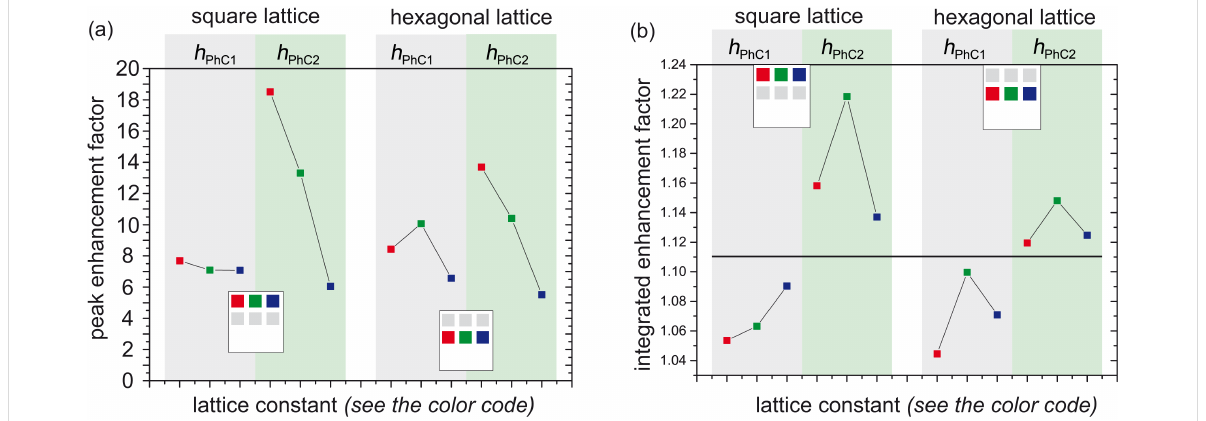
Figure 5: (a) The peak enhancement factor defined as a ratio of the leaky mode extracted PL intensity at the peak maximum to the PL intensity of the reference at the similar wavelength of the fabricated samples. (b) The integrated enhancement factor defined as a ratio of the area below the PL curve of the PhC to the area below the PL curve of the unpatterned reference SiNC-rich layer, both collected in a half angle of 6.9°. The horizontal line divides the results for the sample with shorter ( h PhC1 ) and longer ( h PhC2 ) columns.